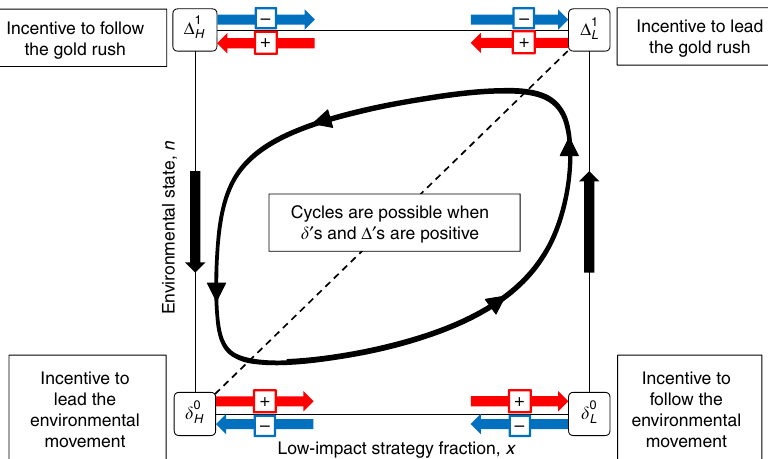
Fig. 1 A graphical illustration of how incentive parameters in eco-evolutionary games in fl uence dynamics. The horizontal axis of the state space corresponds to the frequency of individuals using the strategy with low impact on the environment, whereas the vertical axis indicates the quality of the environment, n , with the dashed line representing the attracting environmental nullcline. Each of the four incentive parameters ( δ 's and Δ 's) control the direction and magnitude of strategy dynamics at a corner of the state space: strategy dynamics follow the red arrows when the corresponding δ or Δ is positive, and blue arrows when negative. When all are positive, meaning there are incentives to lead and to follow strategic changes, then some form of cyclical dynamics seem plausible. However, we show that all δ 's and Δ 's being positive is neither necessary nor suf fi cient for cyclic dynamics in eco- evolutionary